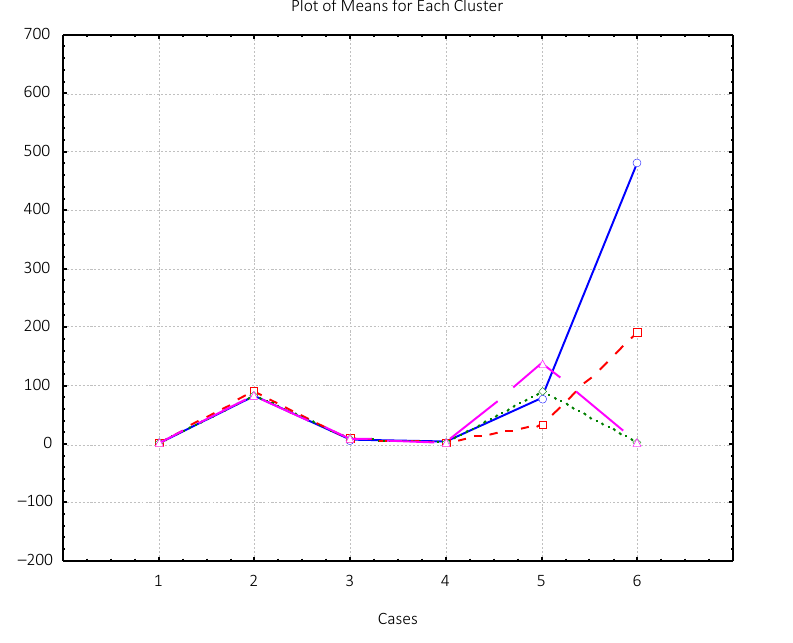
Figure 3. Plot of means for clusters